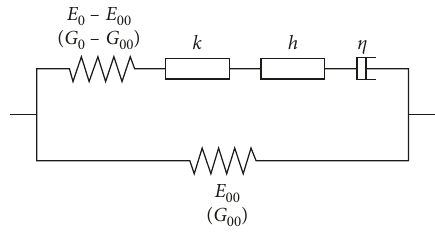
Figure 1: Analogical scheme of 2S2P1D